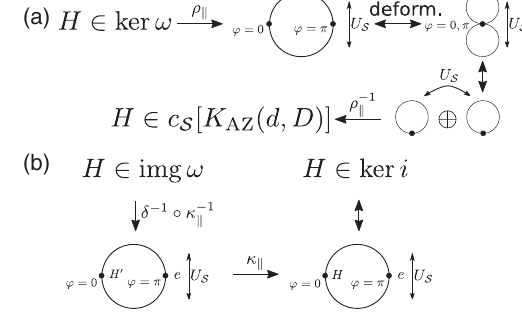
FIG. 11. Hamiltonians from ker ω can be deformed to the form (C2) and vice versa (a). For Hamiltonians from img ω , a path can be constructed that connects them to the trivial element (b). Similarly for every Hamiltonian in ker i , the loop in canonical form can be constructed that yields H from img ω .